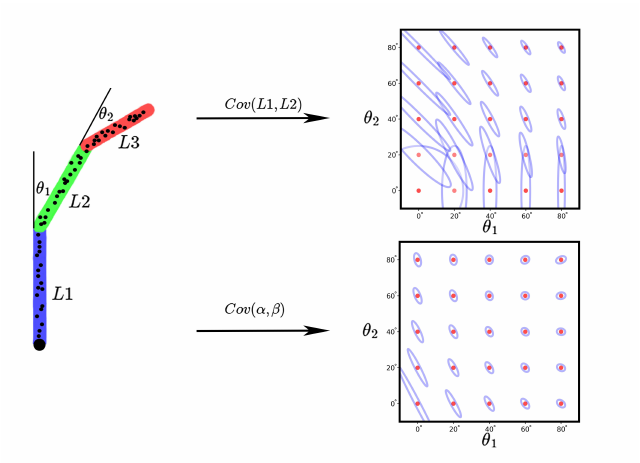
Figure 10. A visualization of the co-variance estimate for simple stick model as we vary the blend angles { θ } . the co-variance ellipsoids are centered at the corresponding { θ 1 , θ 2 shape parameters { L 1, L 2, L 3 } are the length of each stick, and the implicit shape parameters { α , β } are the top two principal components analysis (PCA) components extract on 1000 random generated